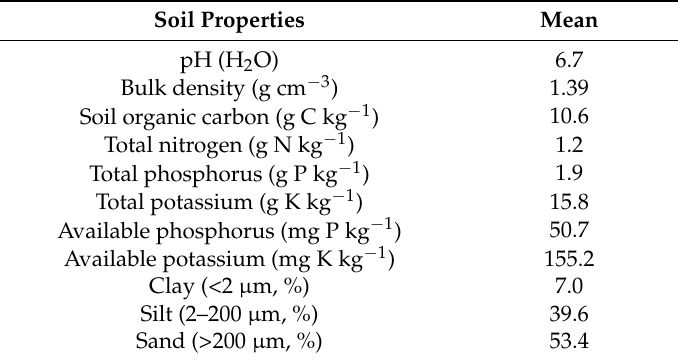
Table 1. Selected soil properties (0–20 cm layer).